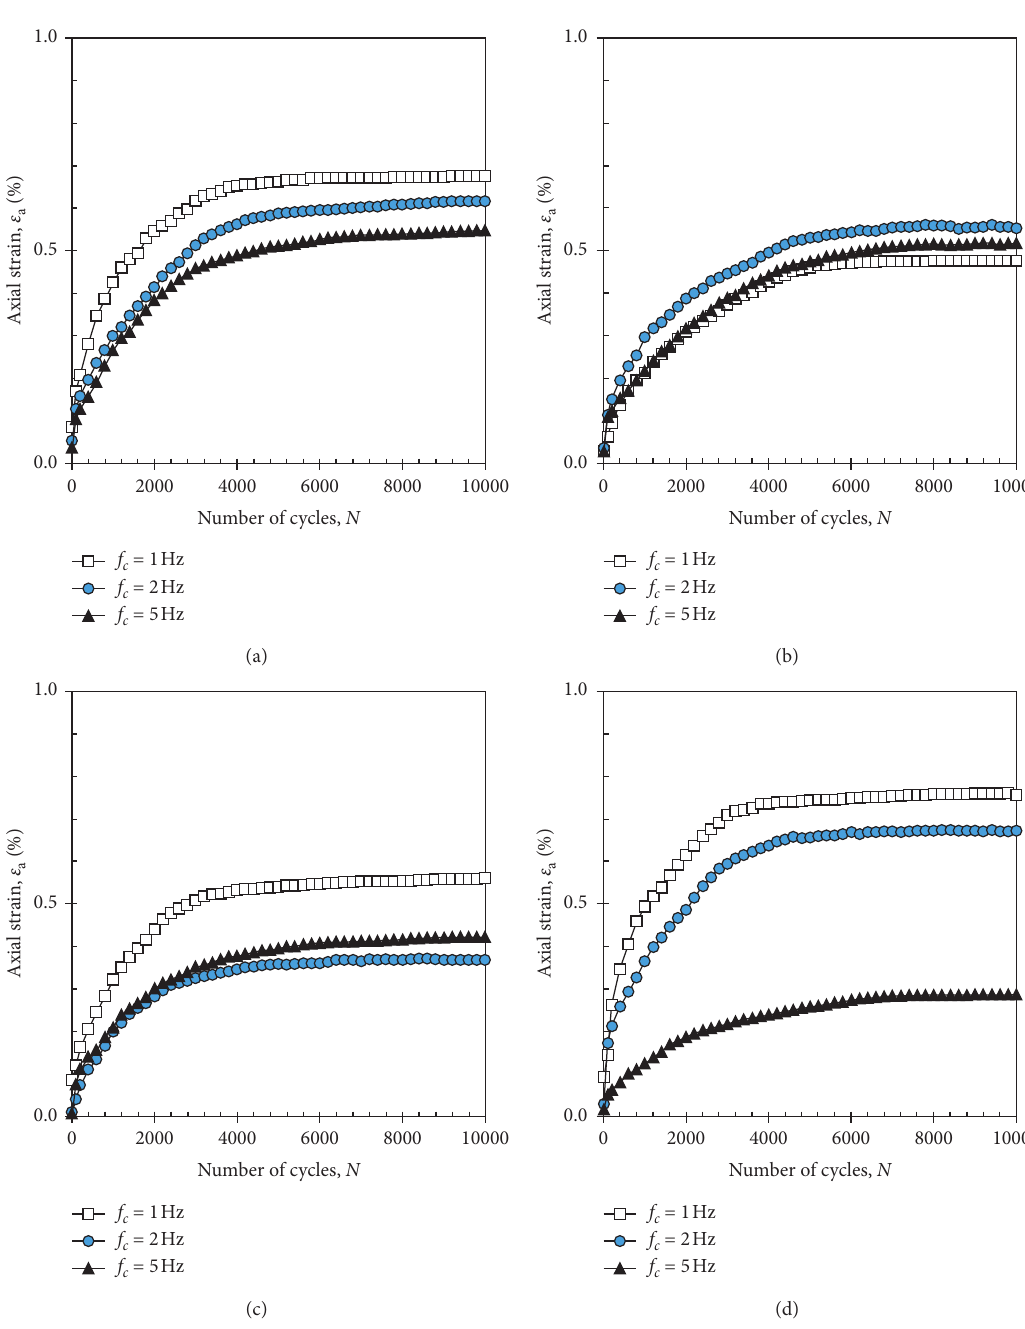
Figure 9: Variation of ε a with N on VDM-treated specimens at f v of (a) 0Hz, (b) 1Hz, (c) 2Hz, and (d)